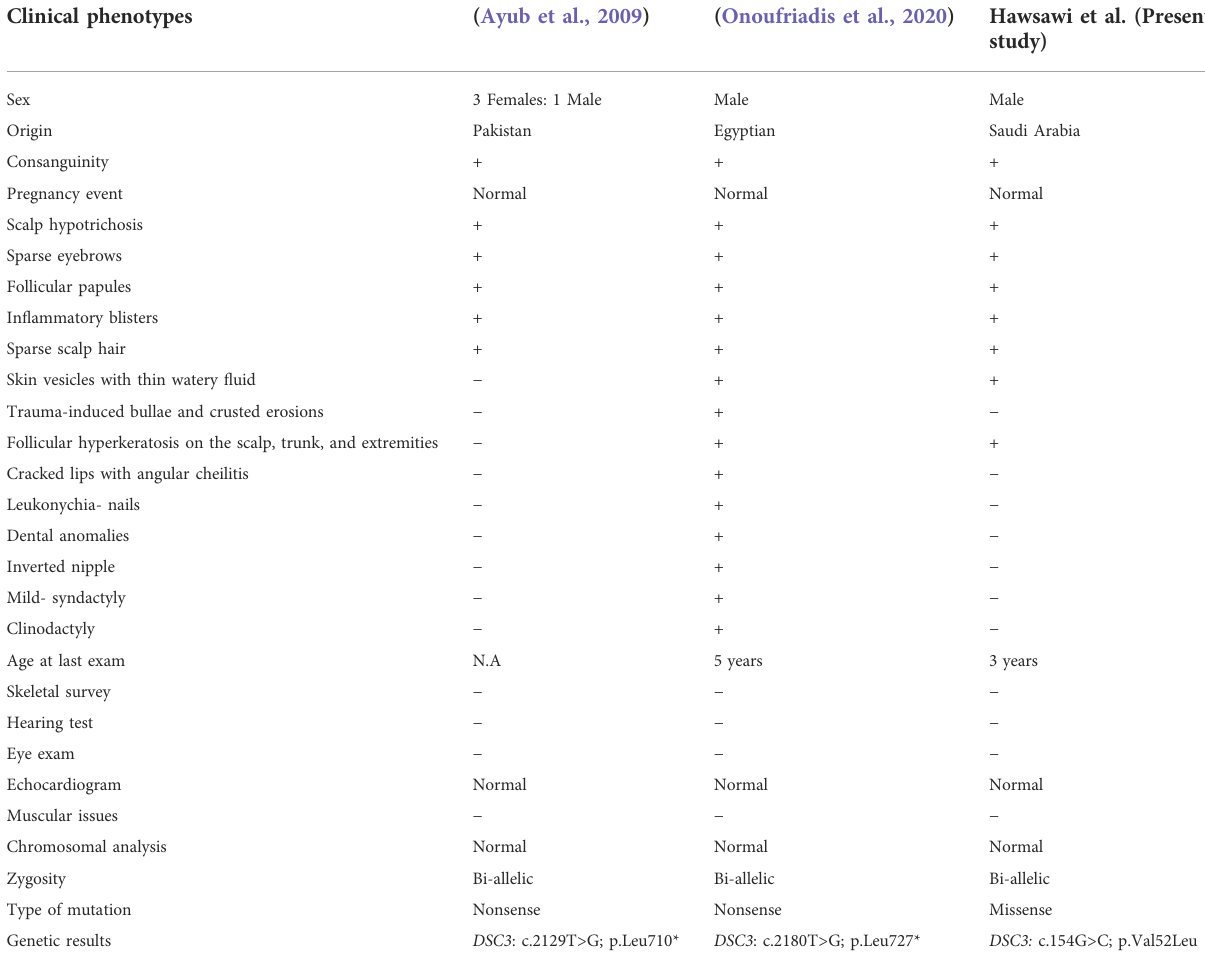
TABLE 1 Comparative clinical description of patients reported to-date. Clinical